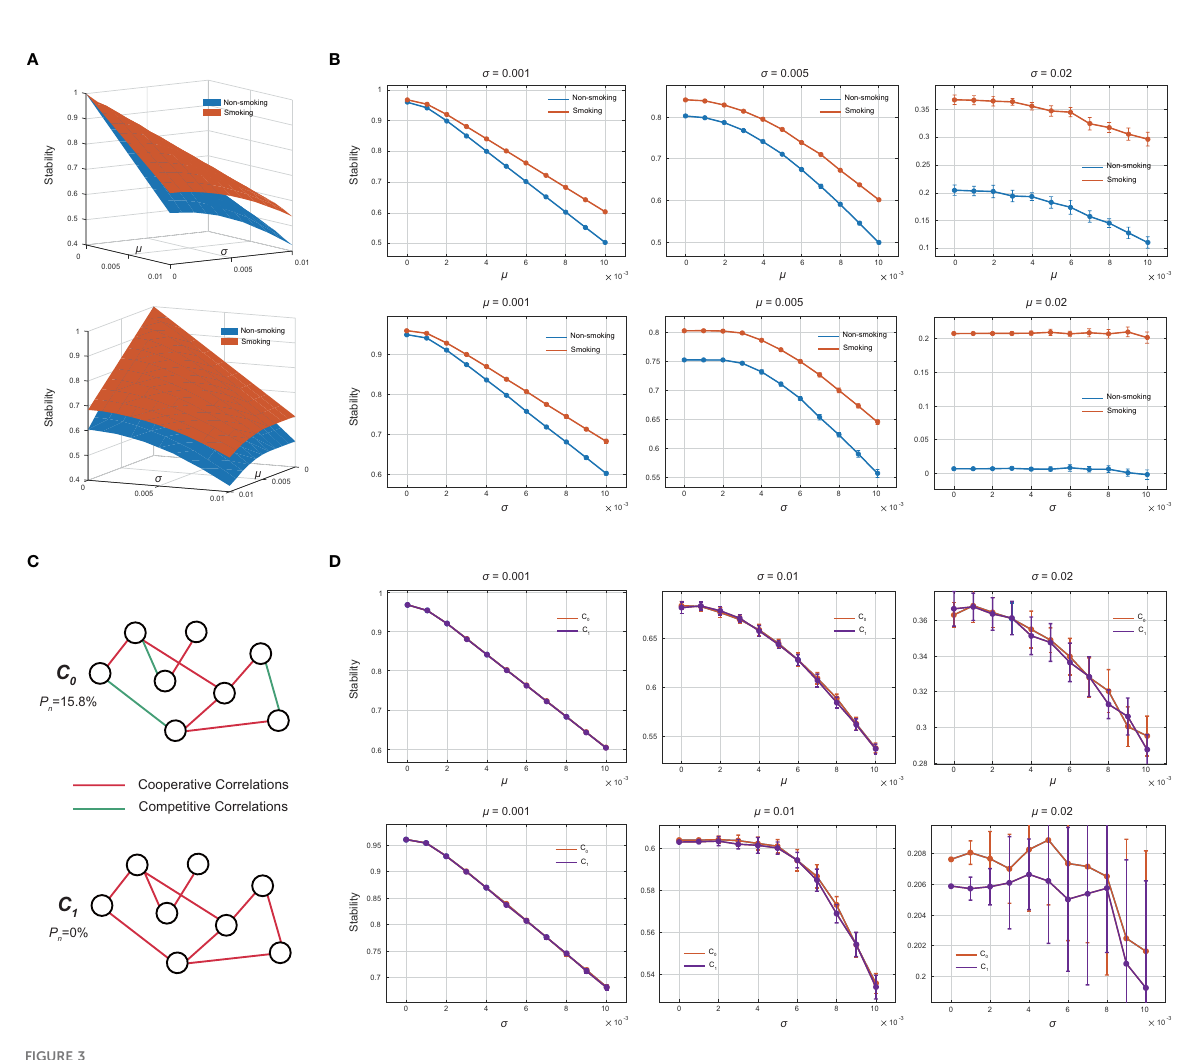
FIGURE 3 (A) The strengths of the bacterial interactions were set to follow a normal distribution N ( m , s 2 ) . By changing the values of m and s (horizontal axes), the stability of the smoking and nonsmoking microbiomes (vertical axis) is represented by two curves. Two perspectives are shown here. (B) Sections from the three-dimensional curves in (a). Each dot on the line represents the mean stability value of 50 simulation repeats. The error bar shows the standard deviation of these repeats. The plot shows a clear tendency for higher stability in the smoking microbiome than in the nonsmoking microbiome under various parameter settings. (C) A schematic diagram showing the difference between C 0 and C 1 . C 0 is the original community from the smoking microbiome in our study, with a proportion of negative correlations ( P n ) of 15.8%. C 1 is the virtual community modi fi ed from C 0 by changing all the negative correlations into positive ones. (D) The stability difference between C 0 and C 1 is also visualized. The two curves are very close and intermingled, indicating similar stability between the original and modi fi ed